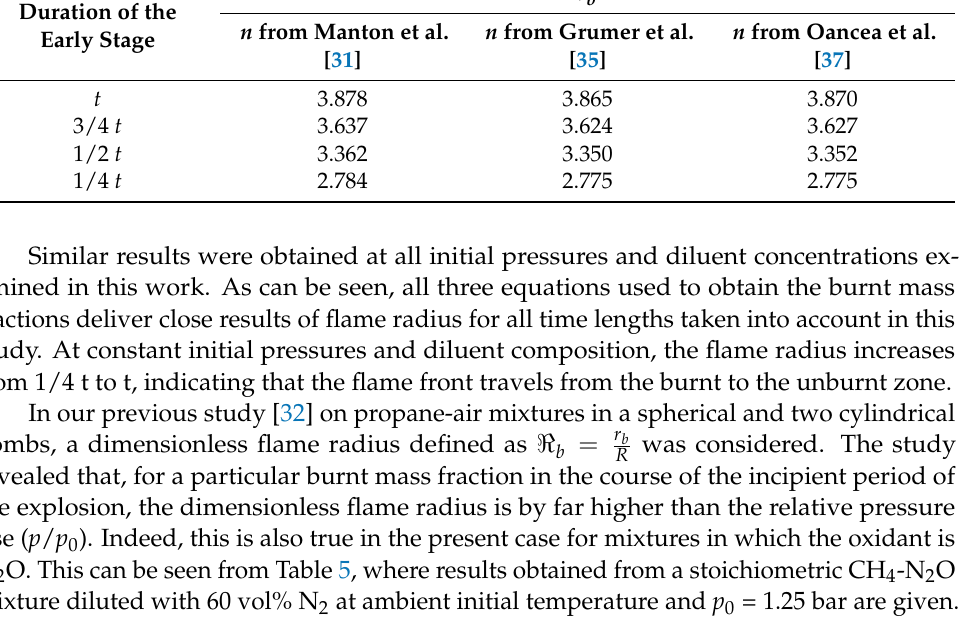
Table 4. The flame radius of stoichiometric CH 4 -N 2 O mixture diluted with 40 vol% N 2 , at atmospheric initial pressure and temperature. Duration of the Early Stage